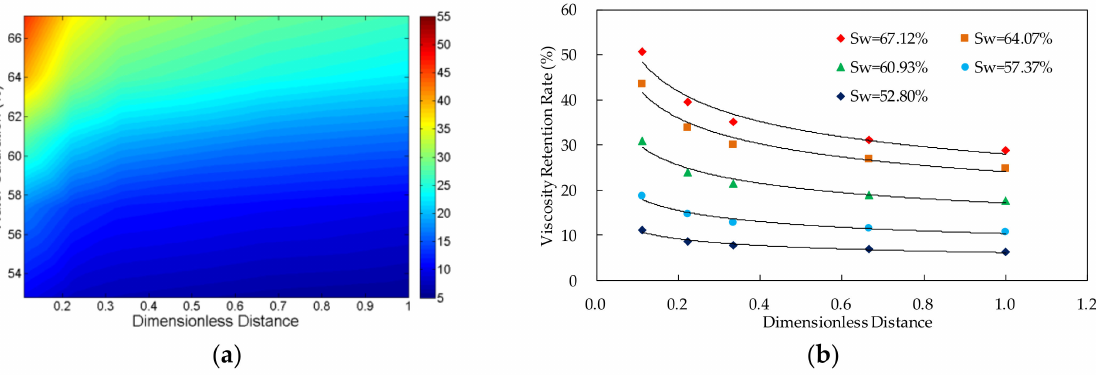
Figure 4. The relationship between viscosity retention rate of polymer solution, dimensionless dis- tance and water saturation in the experiment VV-2 in which the polymer concentration is 1250 mg/L. ( a ) Contour map of viscosity retention rate; and ( b ) scatter plot of viscosity retention rate.